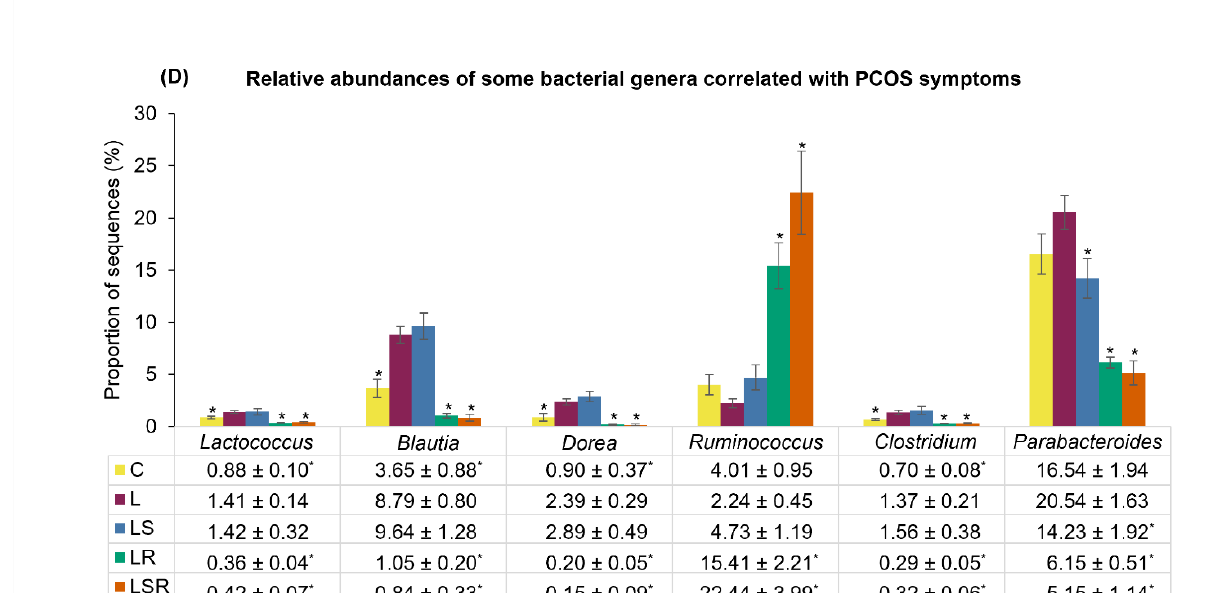
Figure 6. Analyses of gut microbial profiles. The cecal content of each rat, which was collected at the end of the experiment, was used to analyze the gut microbiota composition using 16S rRNA sequencing. Alpha diversity analysis by ( A ) Faith’s PD index and ( B ) Shannon index. ( C ) Beta diversity analysis by Bray–Curtis method. ( D ) Relative abundances of significantly different bacterial genera. All the values are expressed as the mean ± S.E. Statistical analysis was conducted by Kruskal–Wallis test followed by Tukey–Kramer test for multiple comparison analysis. a, b represent p < 0.05 compared to the C group, * represent p < 0.05 compared to the L group.